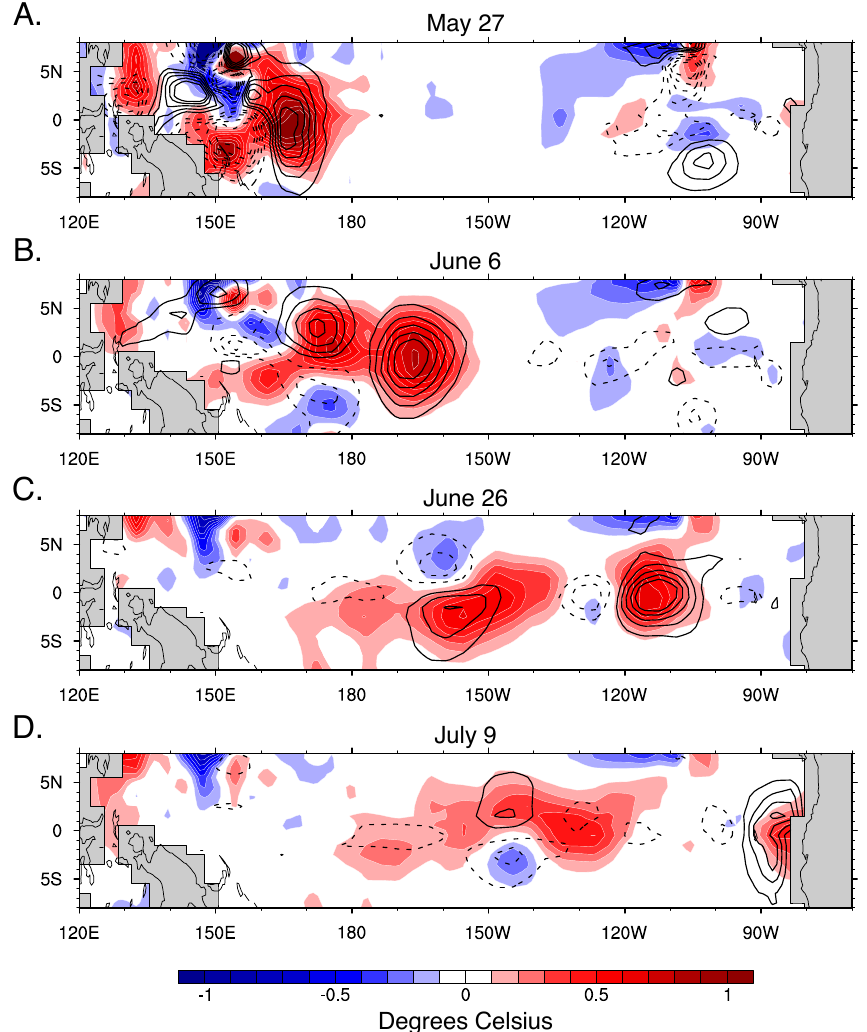
Fig. 2. Upper ocean temperature difference (color contours) between the simulation with TC wind forcing (2X scale factor) and the control for: (A) 27 May 2003, (B) 6 June 2003, (C) 26 June 2003, and (D) 9 July 2003. In all panels, the mean difference between the TC simulation and control has been removed to highlight the transient features. The black contours represent anomalous zonal (eastward) velocity (dashed lines denote negative values). Zonal velocity contour spacing is 2cms − 1 . Both quantities are averaged between 100 and 200m